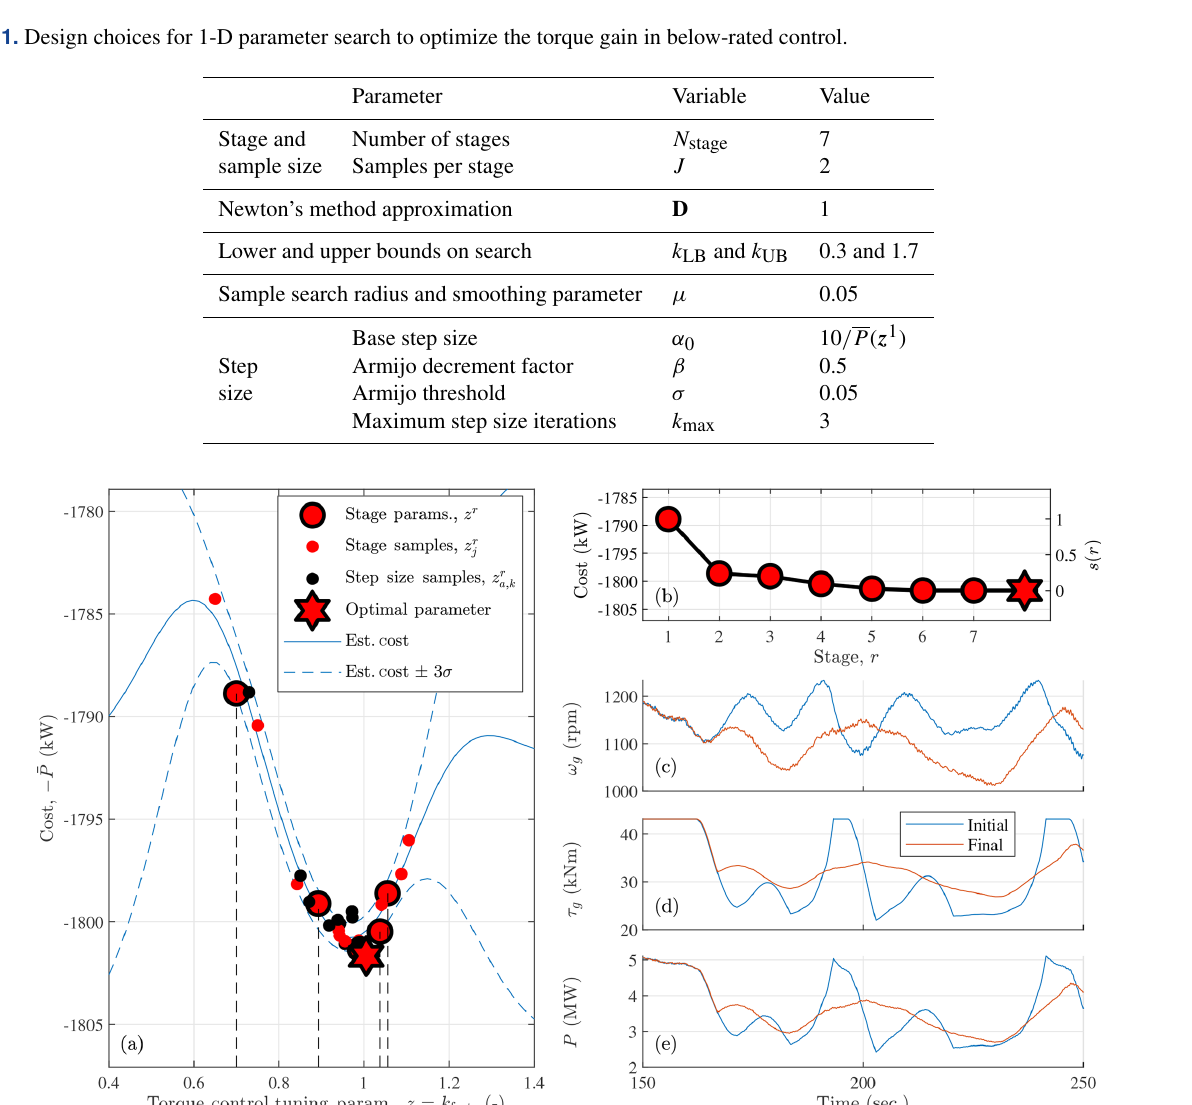
Figure 2. One-dimensional parameter tuning for the optimal torque control gain of the 5MW reference turbine in Class A turbulence using the negative mean generator power ( − P ) as the cost function. In below-rated control, the generator speed ( ω g ) is controlled using the generator torque ( τ g ). The estimated cost and uncertainty are found using Eqs. (13) and (19), respectively, where σ ( z ) = settling function s ( r ) is defined in Eq. (21) and the cost estimate is determined using all of the simulation results (27 unique parameters in 81 total